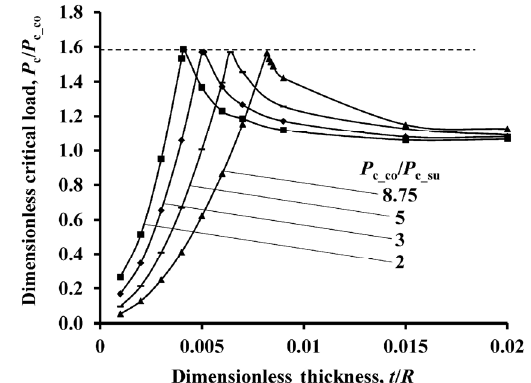
Fig. 2 The ratios of the critical interference, load, L c / P c , for yield inception of ductile materials in full stick over perfect slip [22].